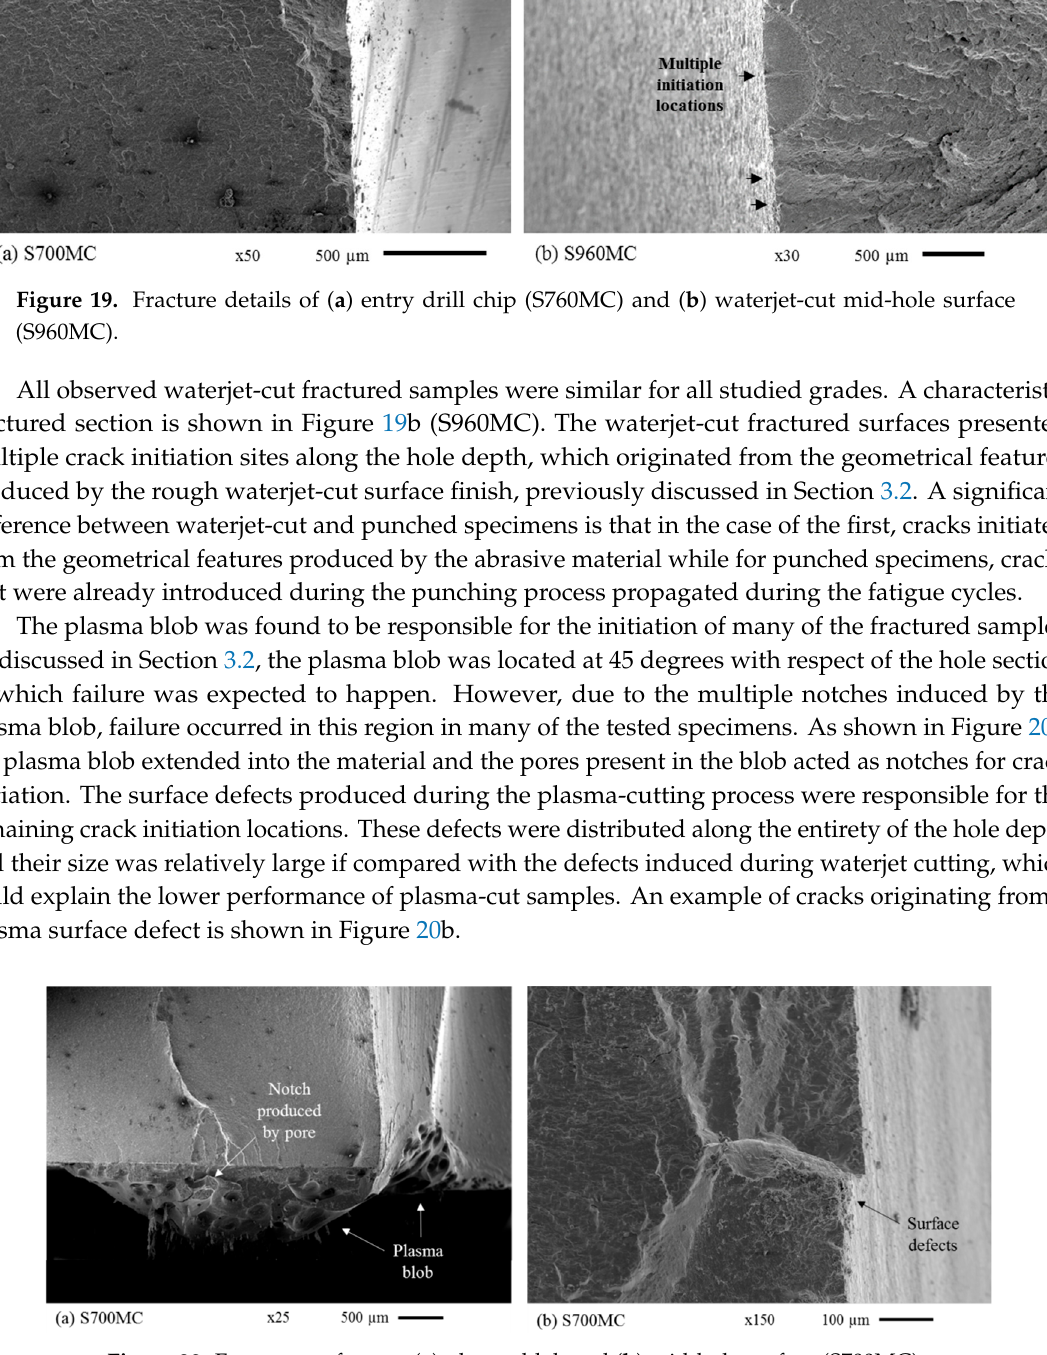
Figure 20. Fracture surfaces at ( a ) plasma blob and ( b ) mid-hole surface (S700MC).